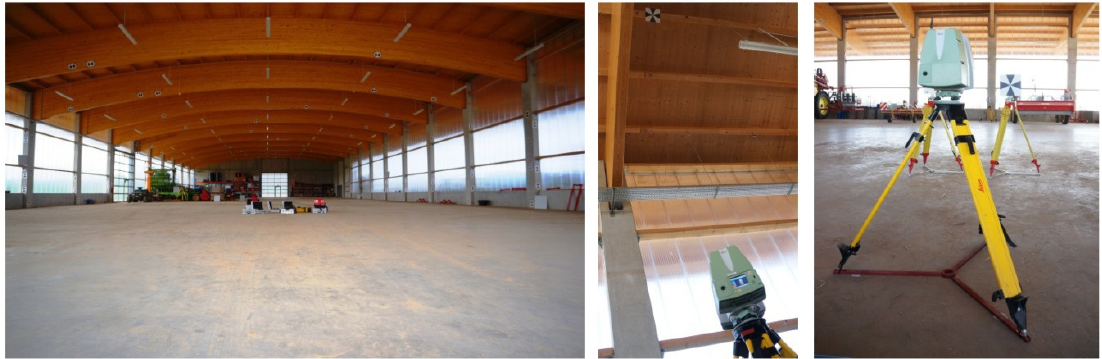
Figure 17. Photo-documentation of the calibration experiment: overview image of the facility (left), scanner station S1 with the target T2 (middle), T1, and T3 (right).